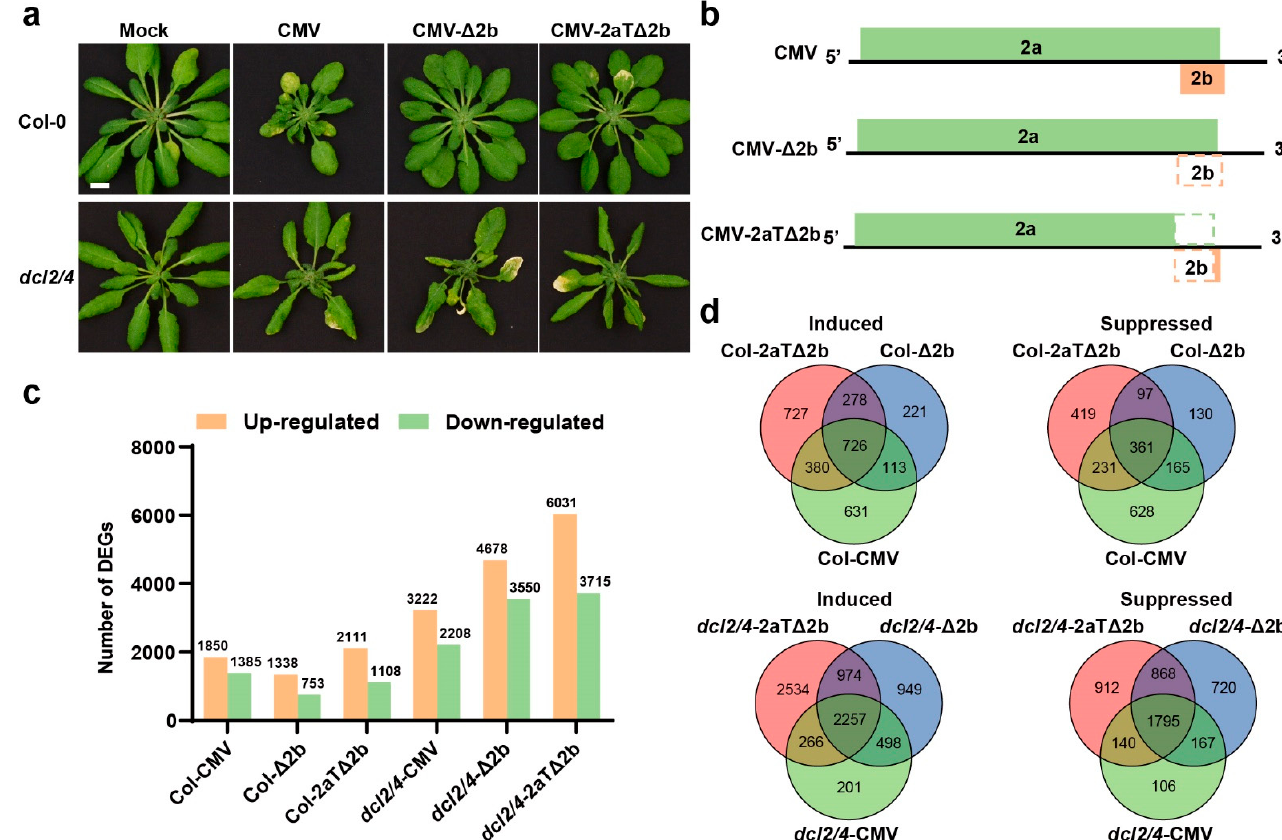
Figure 1. Development and transcriptome of Arabidopsis that were affected by cucumber mosaic virus (CMV) infection. ( a ) Phenotype of Col-0 and mutant dcl2dcl4 ( dcl2/4 ) inoculated with CMV, CMV- Δ 2b and CMV-2aT Δ 2b. Bar = 1 cm. ( b ) The RNA2 genome structures of CMV, CMV- Δ 2b and CMV-2aT Δ 2b. ( c ) Number of differentially expressed genes (DEGs) in CMV-, CMV- Δ 2b-, and CMV- 2aT Δ 2b-infected plants (Col-CMV, Col- Δ 2b, Col-2aT Δ 2b, dcl2/4 -CMV, dcl2/4 - Δ 2b, and dcl2/4 - 2aT Δ 2b) compared to control plants (Col-Mock and dcl2/4 -Mock). ( d ) Venn diagram analysis of genes number of differentially expressed genes (DEGs) among different gene sets in CMV-, CMV- Δ 2b-, and CMV-2aT Δ 2b-infected plants.